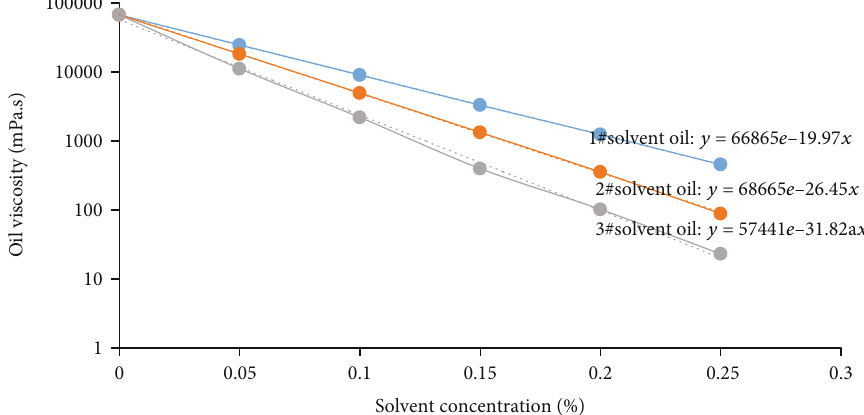
Figure 2: Oil viscosity of di ff erent solvent proportion with oil (50 ° C).